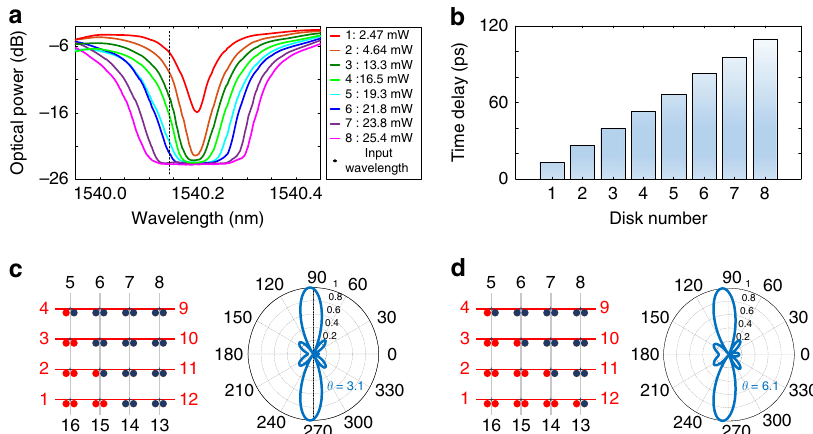
Fig. 4 Experimental results with photonic FPDA signal processor operating as optical beamforming network. a Measured transmission spectrum of the channel from port 4 to port 9 when the voltages are controlled to make resonance wavelength of each MDR aligned progressively. b Measured time delays with the number of the aligned MDRs increasing progressively. c Calculated array factors of a four-element linear PAA when the channel time delay is 13.5 ps. d Calculated array factors of a four-element linear PAA when the channel time delay is 26.4 ps.